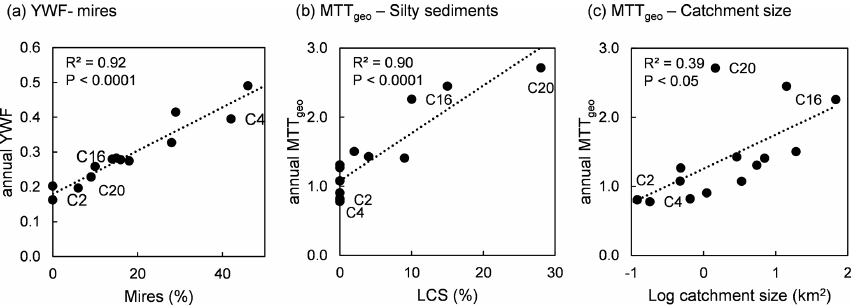
Figure 8. Catchment characteristics are important for travel times. The figure shows the annual averages: (a) the areal coverage of mires and the young water fraction (YWF), (b) areal coverage of silt and MTT geo , and (c) catchment size and MTT geo .